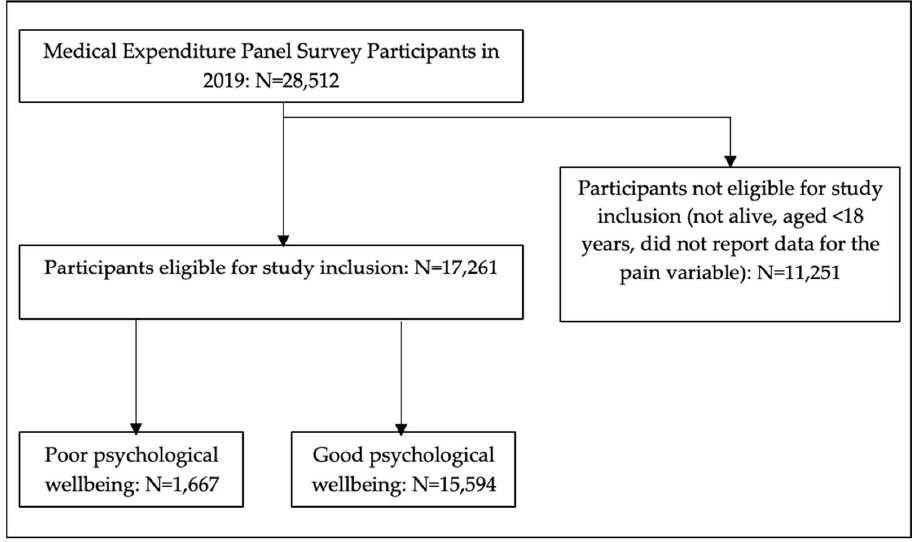
Figure 1. Participant eligibility chart.